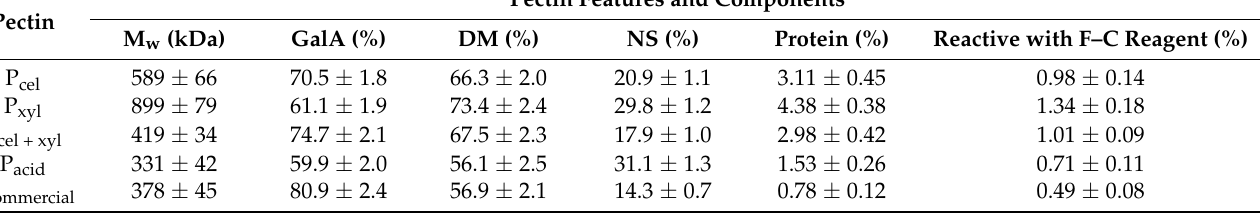
Table 5. Basic chemical composition ( A ) and neutral sugars profile ( B ) of apple pectins used in the experiments (after Wikiera et al.